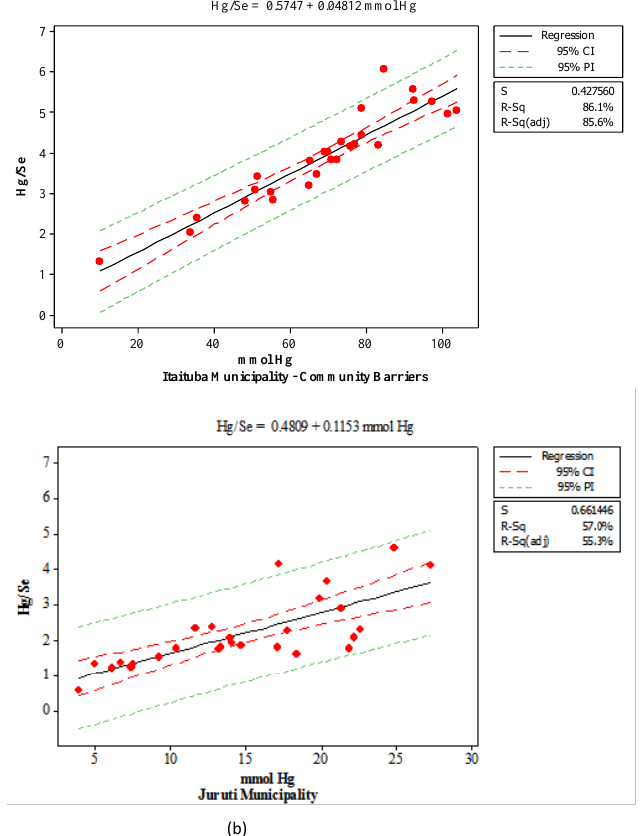
Figure 3: molar ratio Hg/Se and Hg millimole in hair samples of riverine inhabitants belonging to (a) Itaituba municipality - Barreiras community (area impacted by gold mining underground) and (b) Juruti municipality - Tabatinga community (area without mining impact) (masculine genus and feminine genus), belonging to the Tapajós basin, Pará state (Amazon,